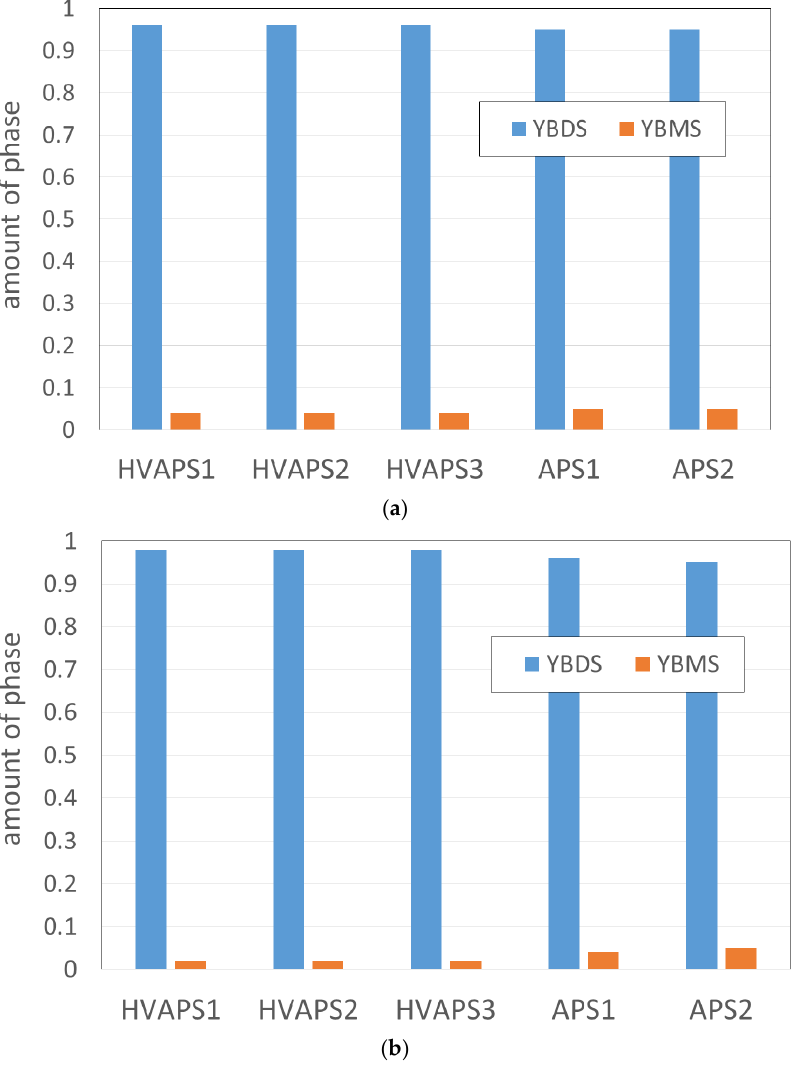
Figure 6. Amount of crystalline Yb 2 Si 2 O 7 (YbDS) and Yb 2 SiO 5 (YbMS) phases in the as-sprayed coatings ( a ) and after heat-treatment at 1300 °C for 100 h ( b ).